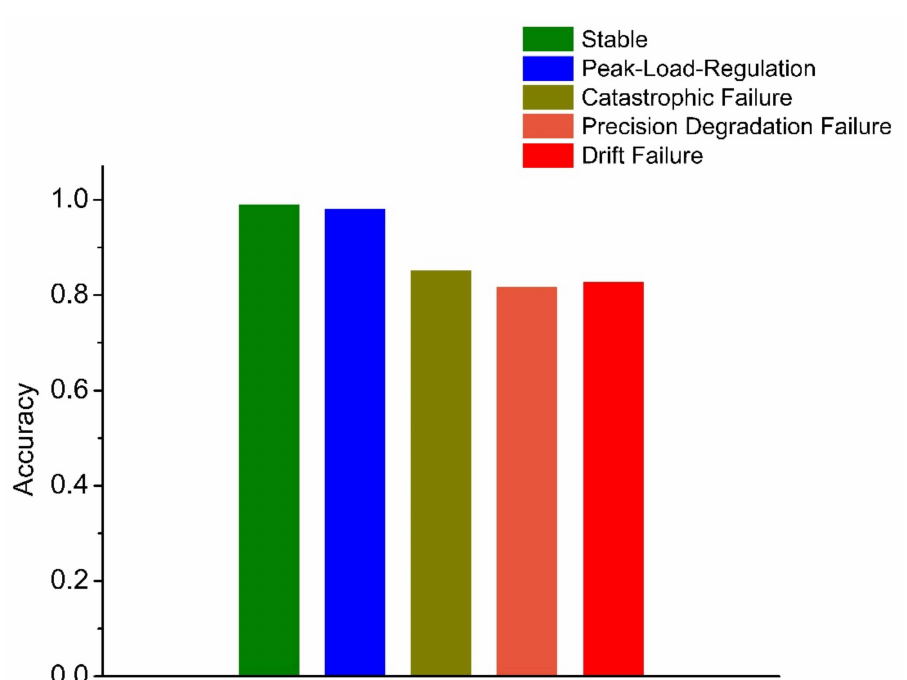
Figure 22. Result of